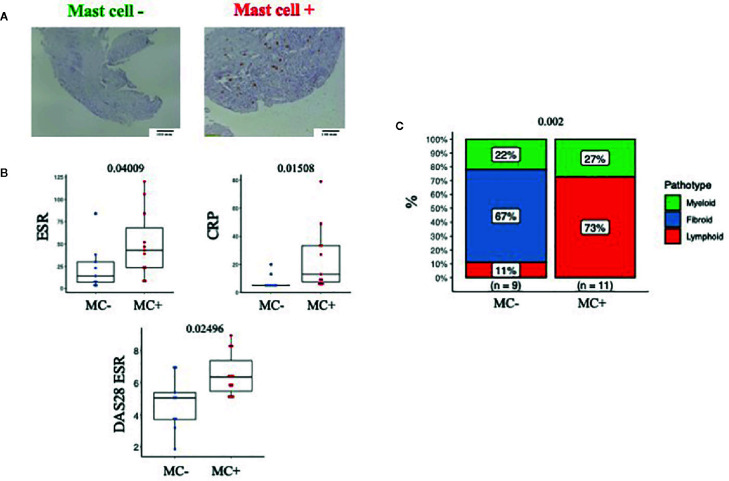

(A) Representative example of IHC staining for CD117 (c-kit) and classification of patients into MC-ve (left) and MC+ve (right). Line at 100um. (B) ESR, CRP and DAS28 in MC-ve and MC+ve patients. n=20 patients, pre-treatment synovial biopsy. ESR, Erythrocyte Sedimentation Rate; CRP, C Reactive Protein; DAS28, Disease activity score 28 joints. (C) Pathotype distribution in MC-ve and MC+ve patients.Mann Whitney test in B, Fisher in C, p value is displayed when significant (<0.05), ns, non-significant (>0.05).